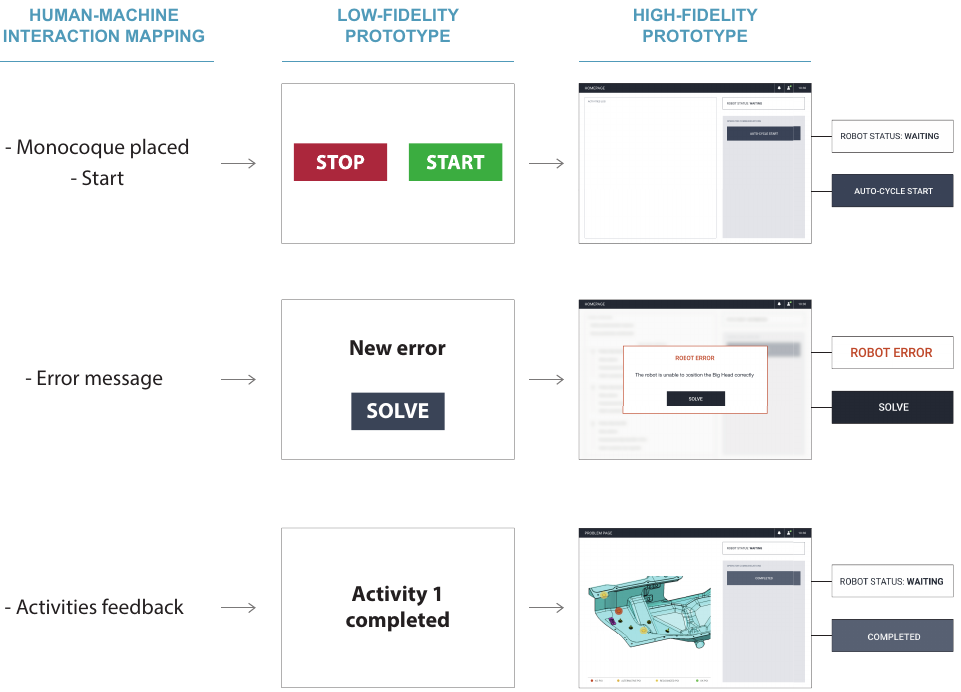
Figure 15. Interface design flow with some screens of the low-fidelity and high-fidelity prototypes of the case